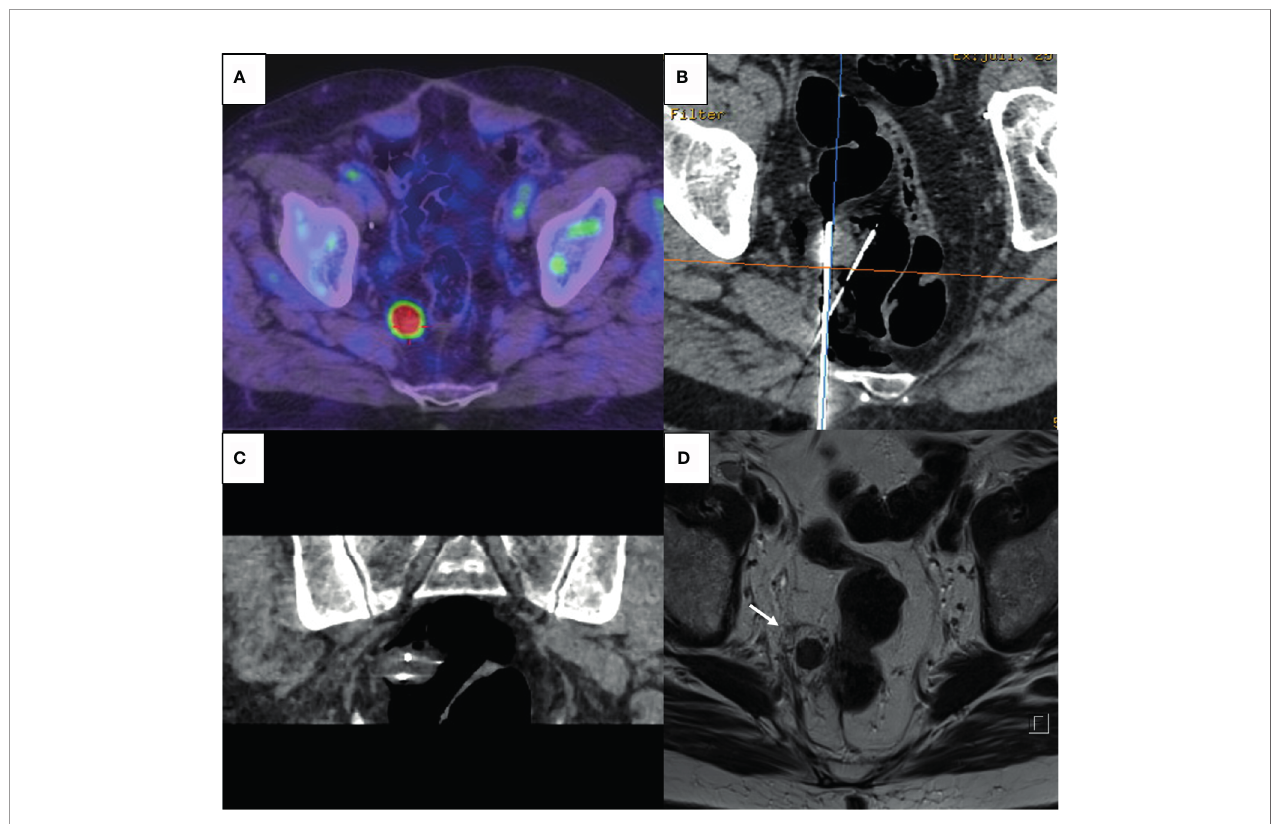
FIGURE 1 | (A) Pre-procedure PET-Choline showing a 2 cm hypermetabolic lymph node abutting the rectal wall. (B, C) CT-guided percutaneous cryoablation with axial view (B) and coronal reconstruction (C) ; two cryoprobes were inserted into the target and CO 2 insuf fl ation via a 22-gauge spinal needle was performed to achieve rectal wall displacement and isolation. (D) T2-weighted MRI after 6 weeks showing complete necrosis of the nodule with surrounding halo of cytosteatonecrosis (arrow); absence of complication on the rectal